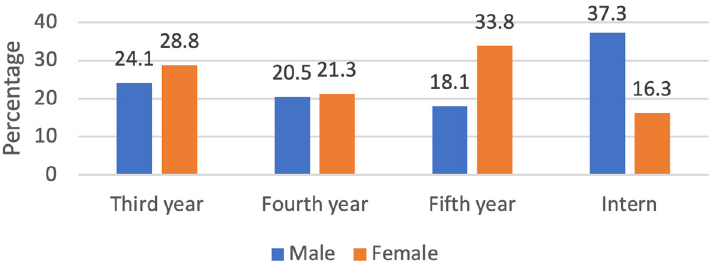
Figure 1. Respondents ‘distribution according to students’ academic year level in relation to gender.